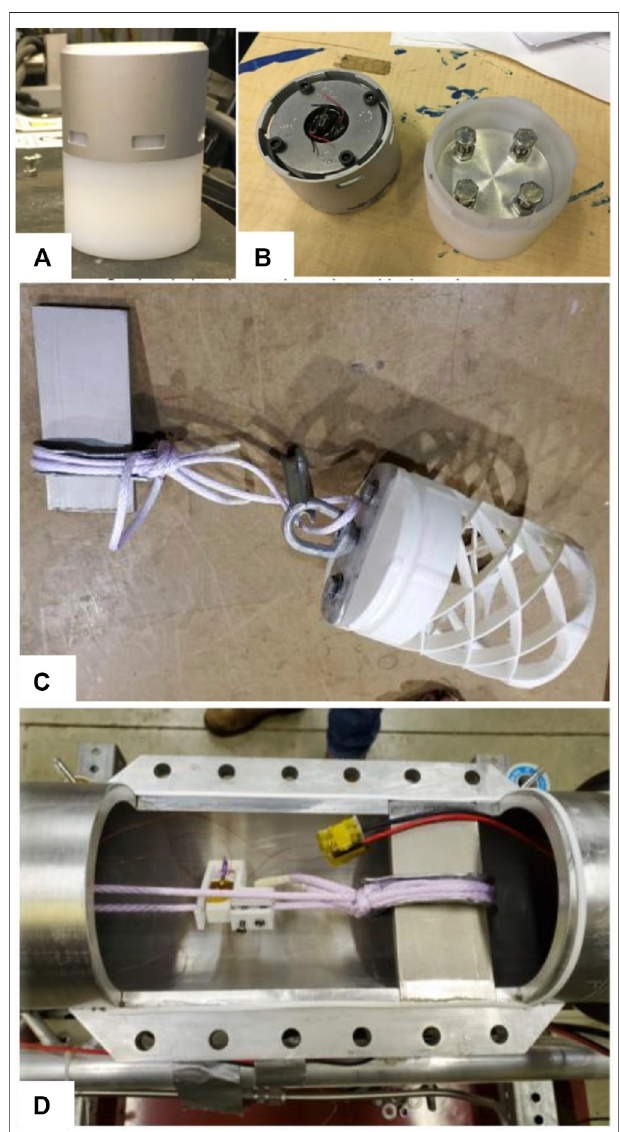
FIGURE2| Impacttestassembly. (A,B) Testarticle#1insidethecarrier. (C) 3D-printed polycarbonate carrier used with tether for test articles #2 and #3. (D) Tether and thermal knife